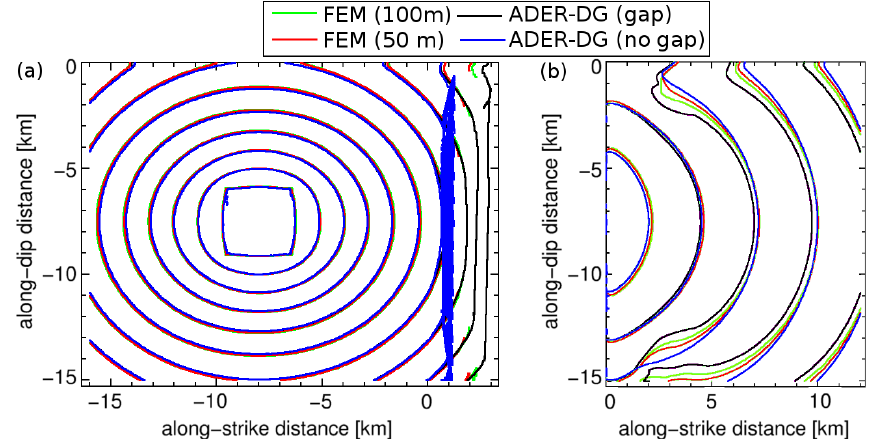
Fig. 9. Rupture time contours of benchmark TPV15 on (a) the main fault and (b) the branch fault. The junction is located at the along-strike distance of 0km. ADER-DG solutions are shown in black (with gap) and blue (without gap), the FEM comparison solutions in red (50m discretization) and green (100m discretization).